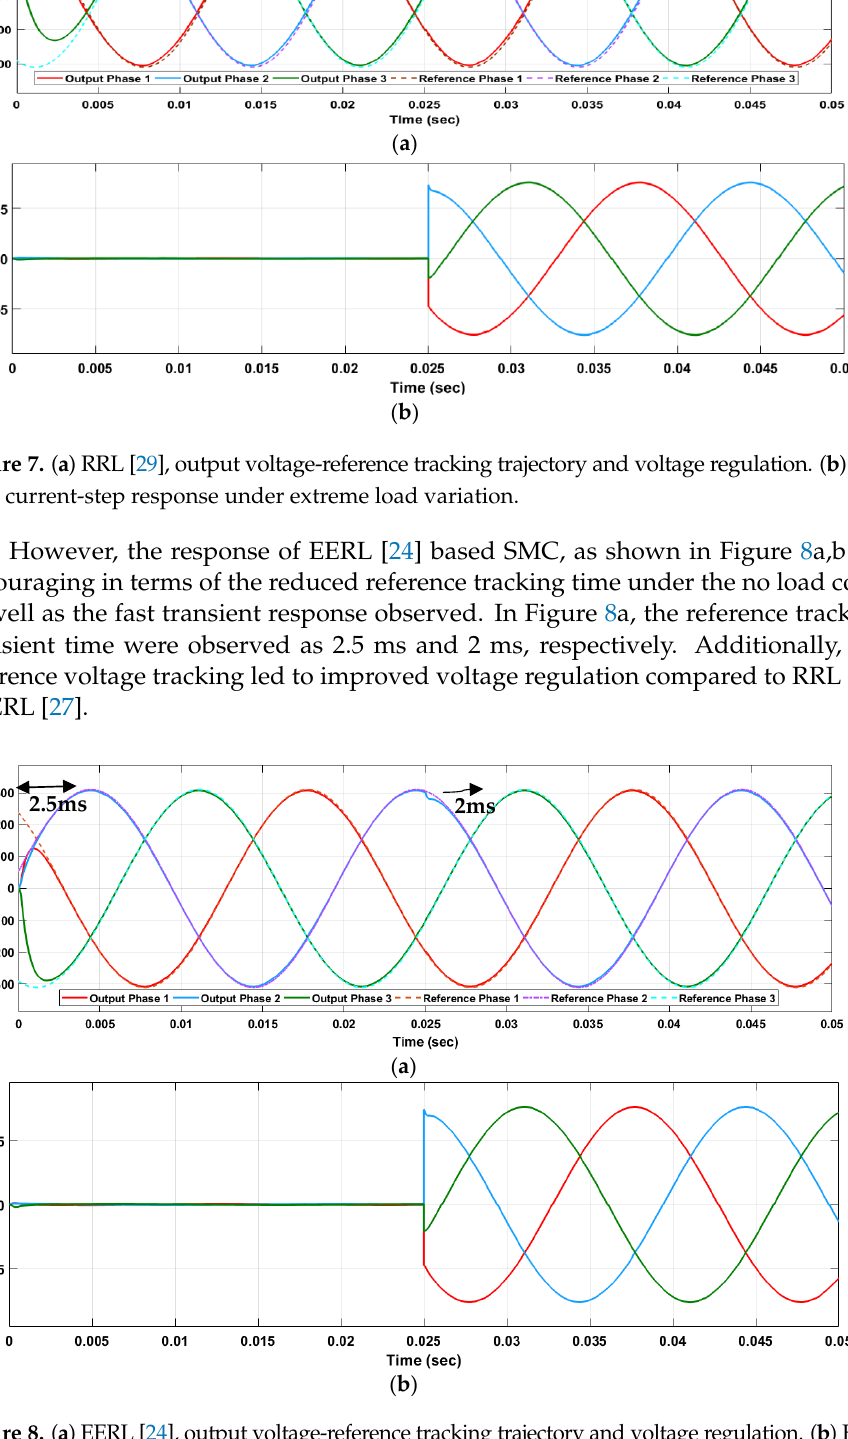
Figure 6. ( a ) PRERL [27], output voltage-reference tracking trajectory and voltage regulation. ( b )